Question: What form of chart is displayed?
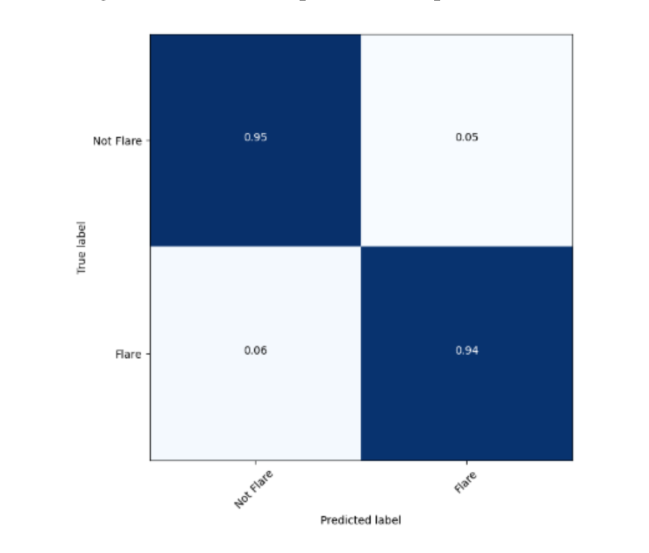
Answer: heatmap